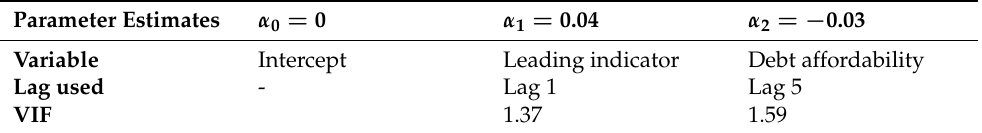
Table 3. Results for the long-run portion of the ECM.